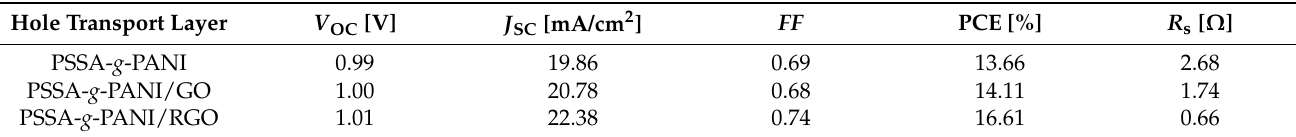
Table 1. Photovoltaic parameters of devices with varied HTL composites under 1-sun illumination. Hole Transport